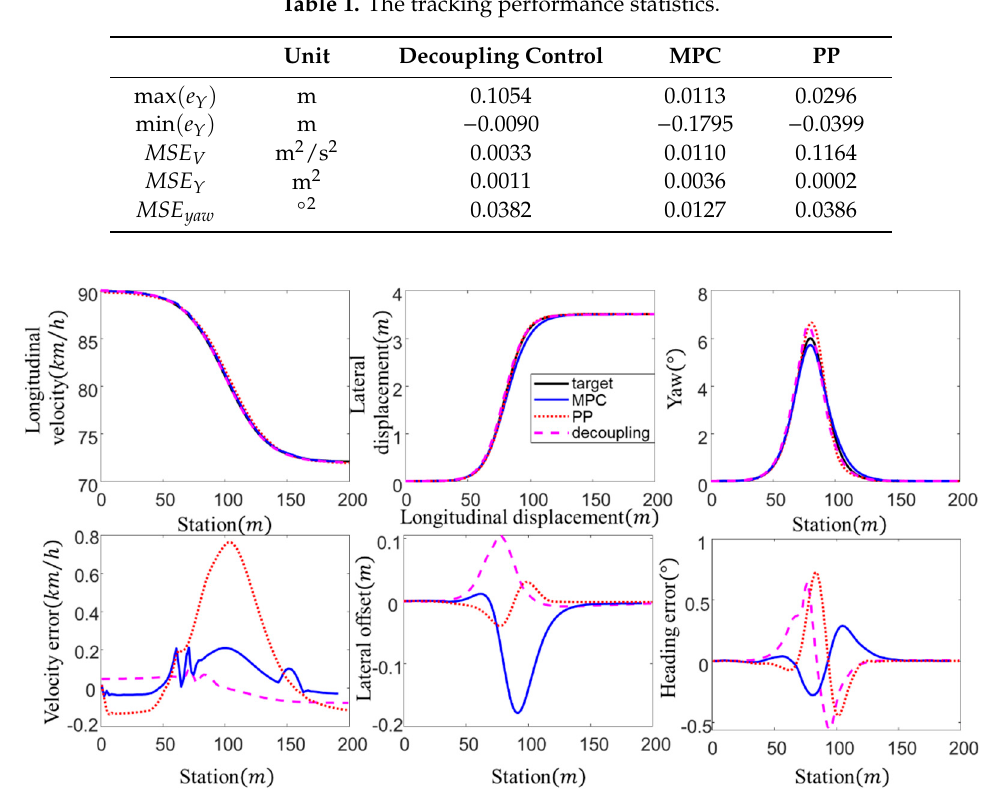
Figure 7. Trajectory tracking results in scenario 1.